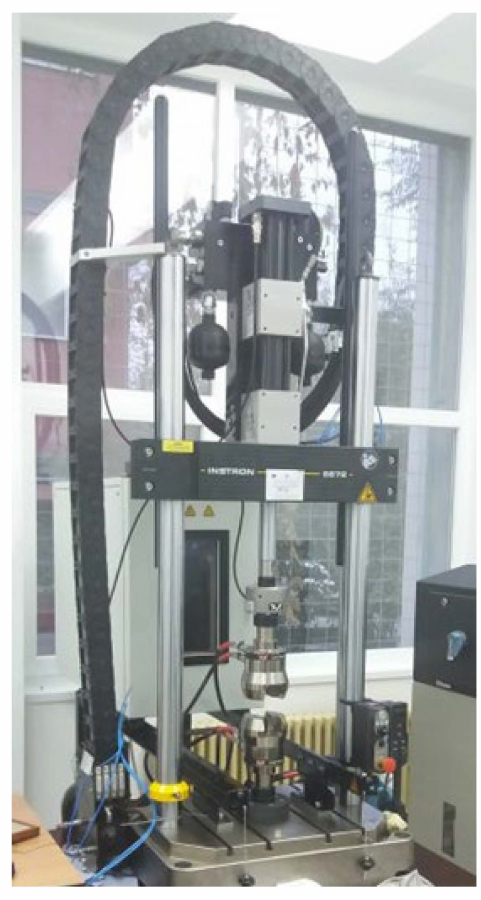
Figure 5. The Instron 8872 servo hydraulic testing system